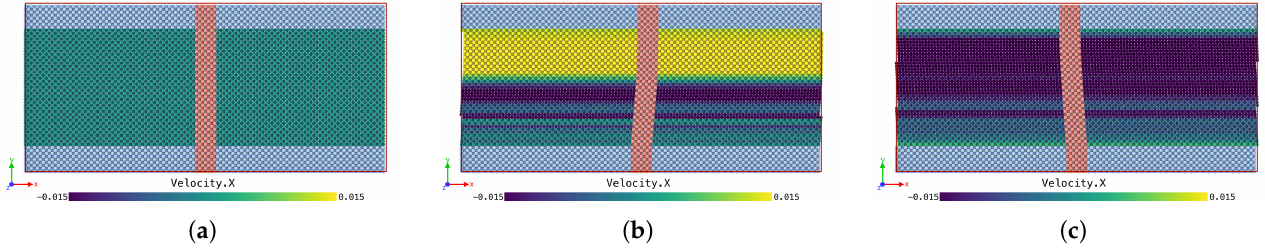
Figure 9. Illustration of set of particles tracked during the oscillatory test in a pure elastic substance. Particles not included in the timelines have been coloured by velocity in x − direction, at three different time instants. ( a ) t = 0s. ( b ) t = 5 × 10 − 5 s. ( c ) t = 4.5 × 10 − 4 s.